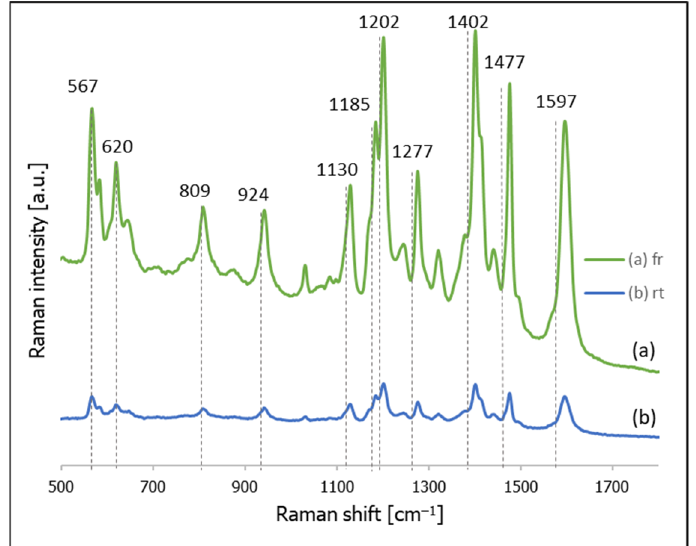
Figure 2. SERS spectra of thiolated DNA modified with Cy3 at the 5 ′ end adsorbed on gold nanoparticles: ( a ) using a freezing step, and ( b ) room temperature incubation.